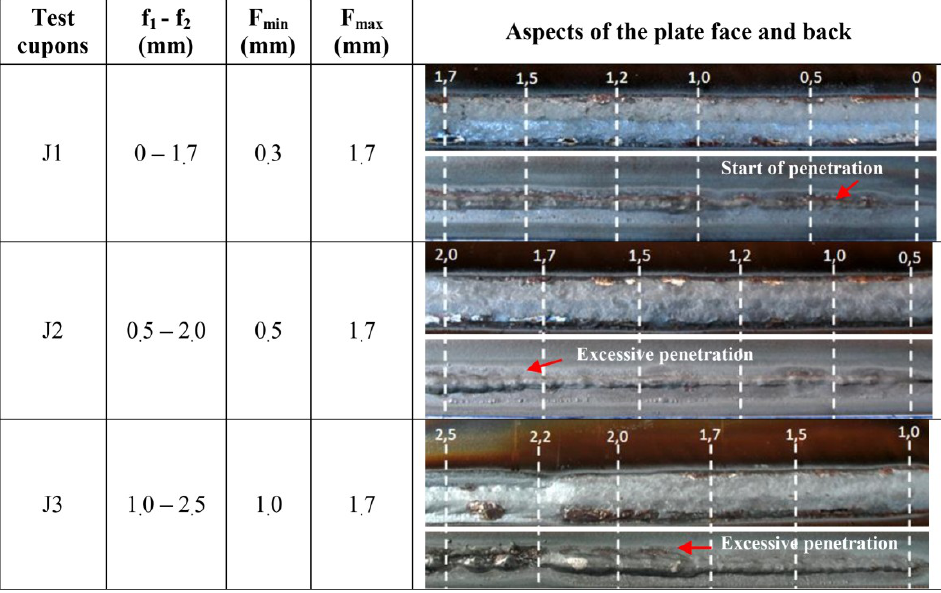
Figure 3. Quantification of the operational gap range for the experiment 1L (linear torch movement).